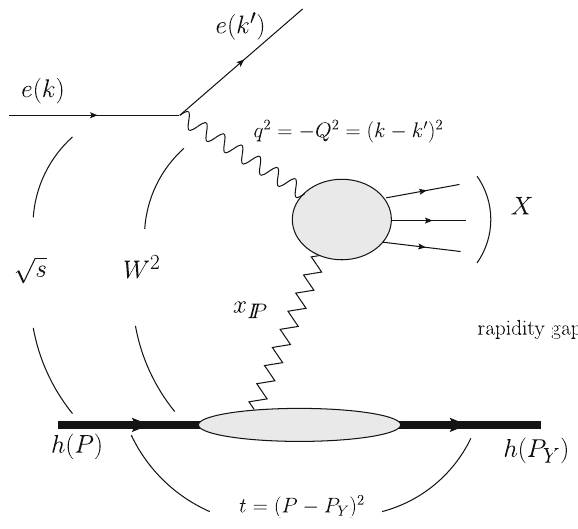
Fig. 1 Diffractive deeply inelastic scattering in electron-hadron colli- sions, where the hadron can be in particular a proton or a nucleus